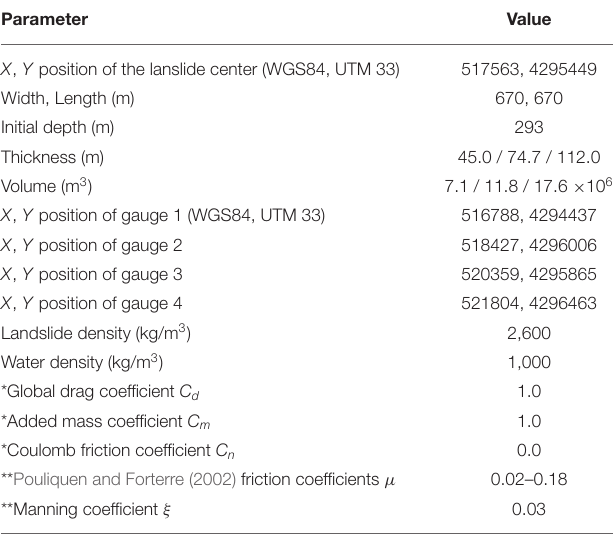
TABLE 5 | Geometric and physical parameters characterizing the three scenarios of a submarine landslide studied by Fornaciai et al. (2019). Parameter Value X , Y position of the lanslide center (WGS84, UTM